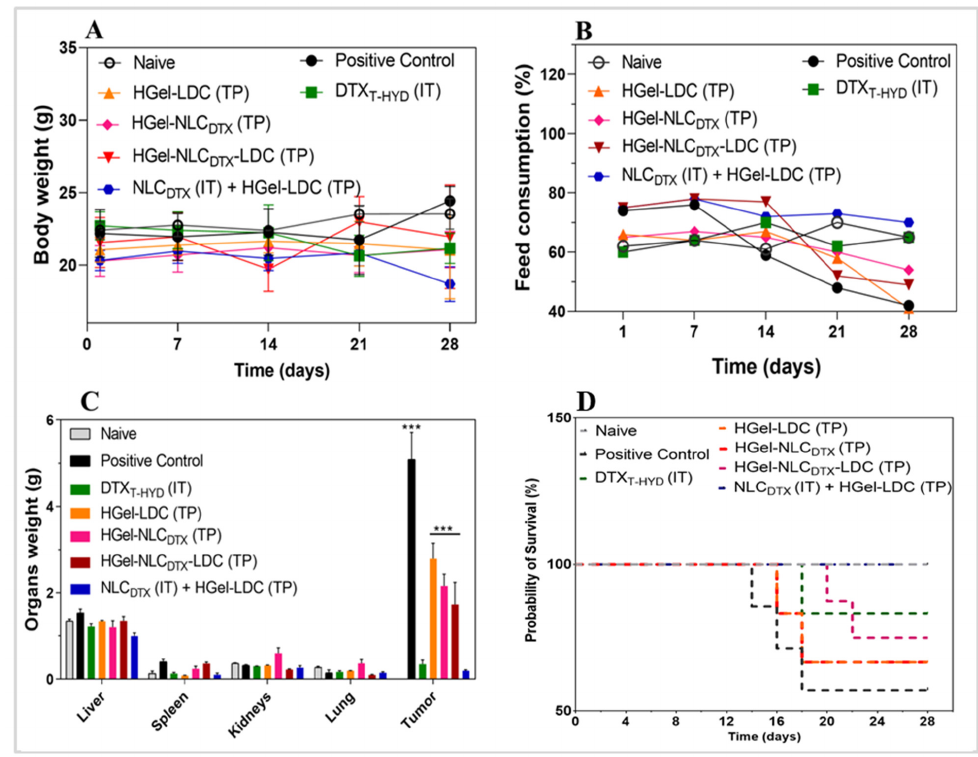
Figure 6. Evaluation of treatments and their adverse effects over C57BL/6J mice with melanoma. ( A ) Variation of body weight ( B ) Analysis of feed intake. ( C ) Weight of the organs (liver, spleen, kidneys, lung) and tumor region. ( D ) Kaplan–Meier survival curves for the different treated groups: naive, positive control (PBS group), positive control, DTX T-HYD IT and nanohybrid hydrogel groups HGel-LDC TP, HGel-NLC DTX TP, HGel-NLC DTX -LDC TP and NLC DTX IT + HGel-LDC TP.